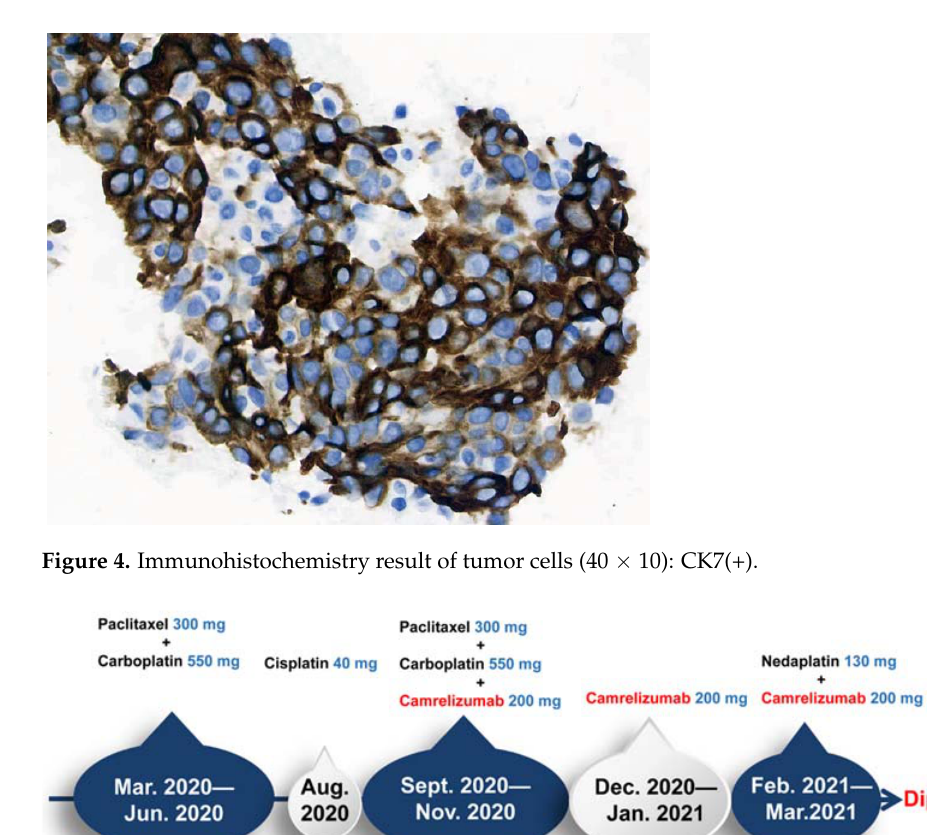
Figure 4. Immunohistochemistry result of tumor cells (40 × 10): CK7(+).